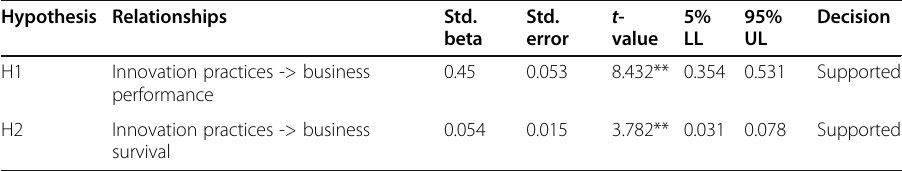
Table 5 Hypothesis testing results Hypothesis Relationships